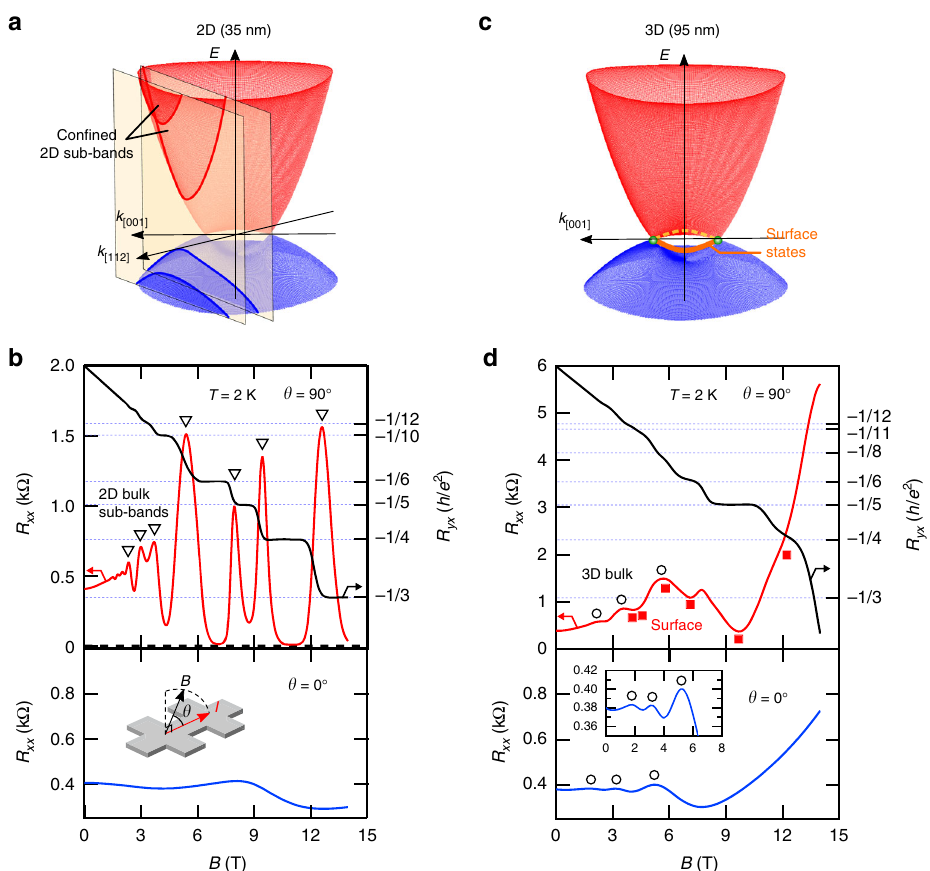
Fig. 3 Quantum Hall effect in 2D and 3D fi lms. a Sub-band formation due to the quantum con fi nement effect in the [112] direction in a thinner fi lm 14 . b Quantum Hall (QH) states developed from the con fi ned bulk states in a 35 nm thick (Cd 1 − x Zn x ) 3 As 2 fi lm ( x = 0.13, θ = 90°, upper panel). The absence of quantum oscillations in the longitudinal magnetoresistance ( θ = 0°, lower panel) indicates the 2D nature of the con fi ned bulk Fermi surface. c 3D Dirac semimetal phase with surface states in a thicker fi lm. d Surface QH states ( θ = 90°, upper panel), and longitudinal magnetoresistance with clear quantum oscillations from the 3D bulk state ( θ = 0°, lower panel) in a 95 nm thick fi lm ( x = 0.15). The QH states develop against the background of bulk